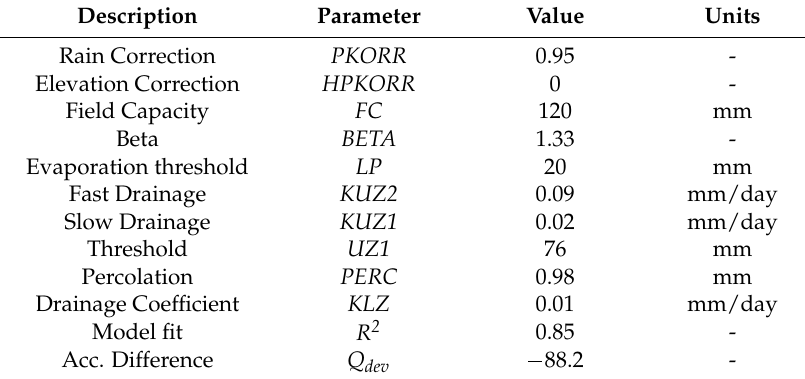
Table 3. HBV calibration parameters for Kwanza Catchment. Dev. denotes the difference in observed total runoff and the simulated runoff during the calibration